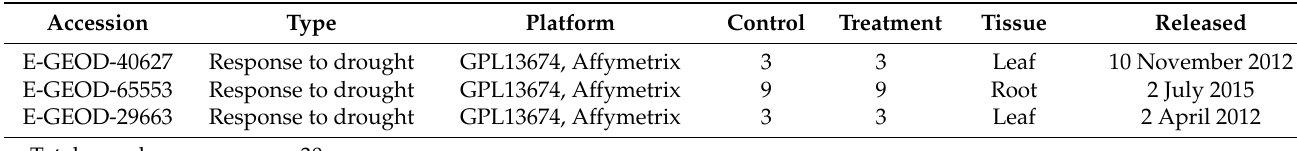
Table 1. Samples retrieved from GEO and